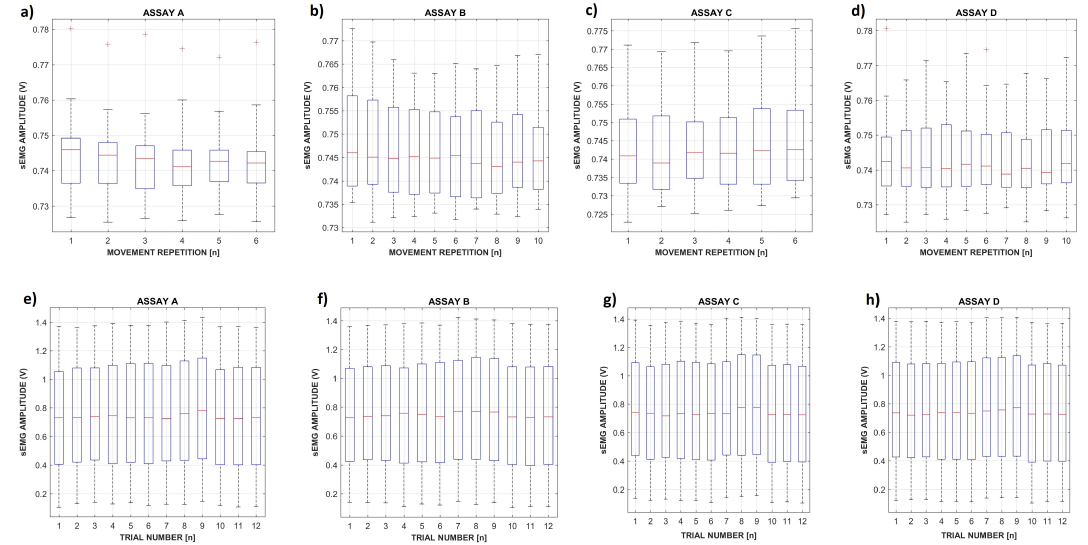
Figure 7. Distribution for sEMG amplitude after the rectification considering the four different assays: The evaluation considers all the movement repetitions and the 12 trials performed, with Trials 1–3, 4–6, 7–9, and 10–12 performed by Subjects 1, 2, 3, and 4,